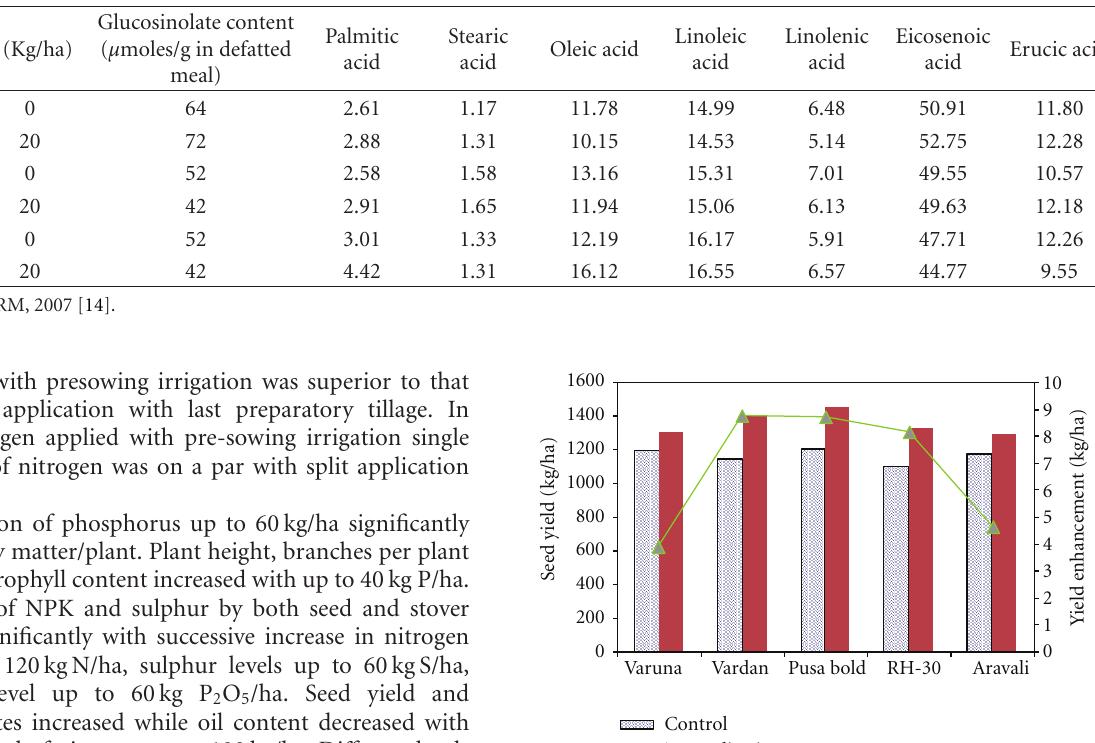
Table 7: E ff ect of N and S levels (kg/ha) application on fatty acid composition and glucosinolate content in Brassica juncea cv. Varuna at Ludhiana.